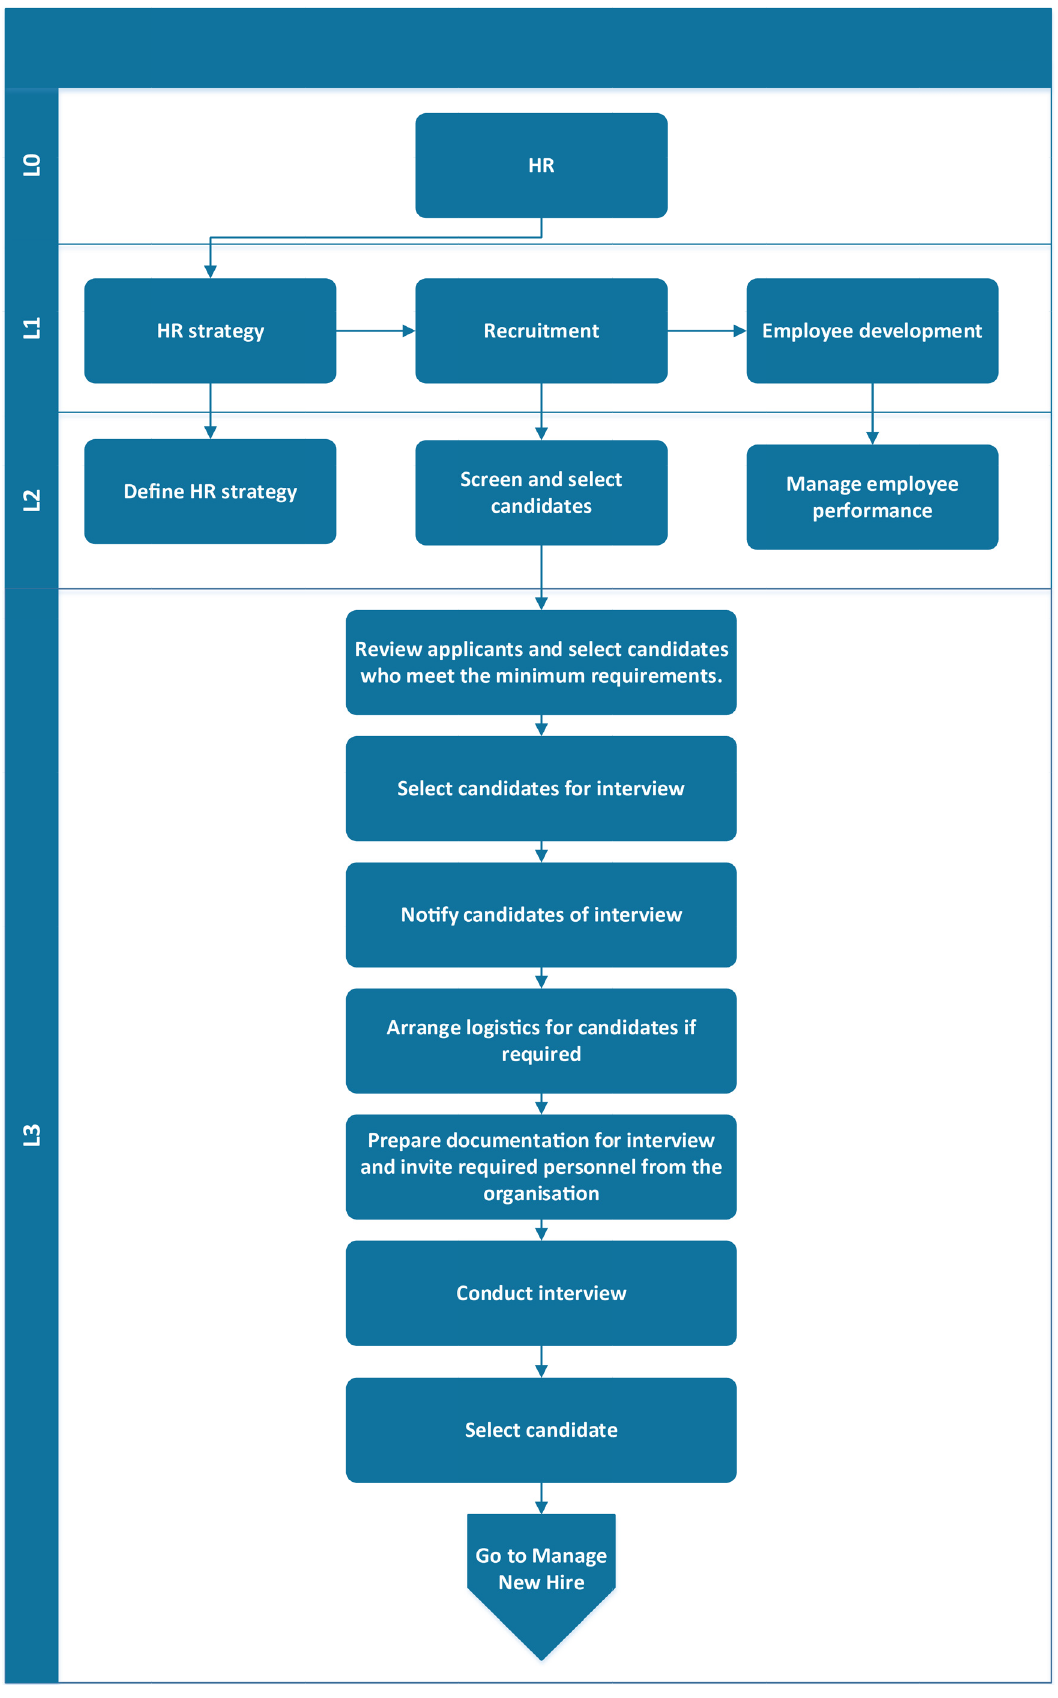
Figure 1. Screen and select candidate business